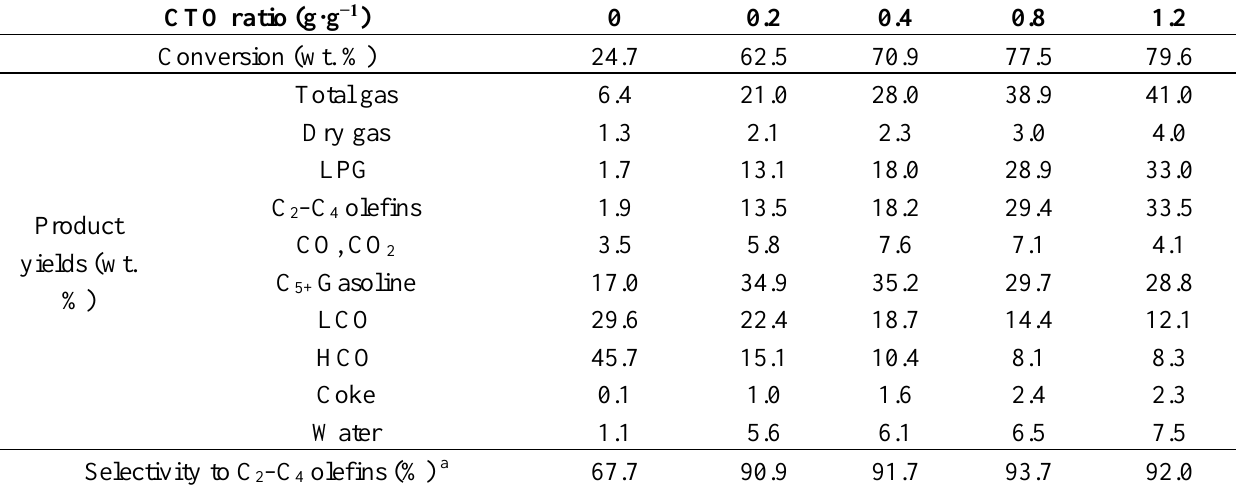
Table 3. The catalytic performance of ZSC-24 catalyst in the cracking of triolein under